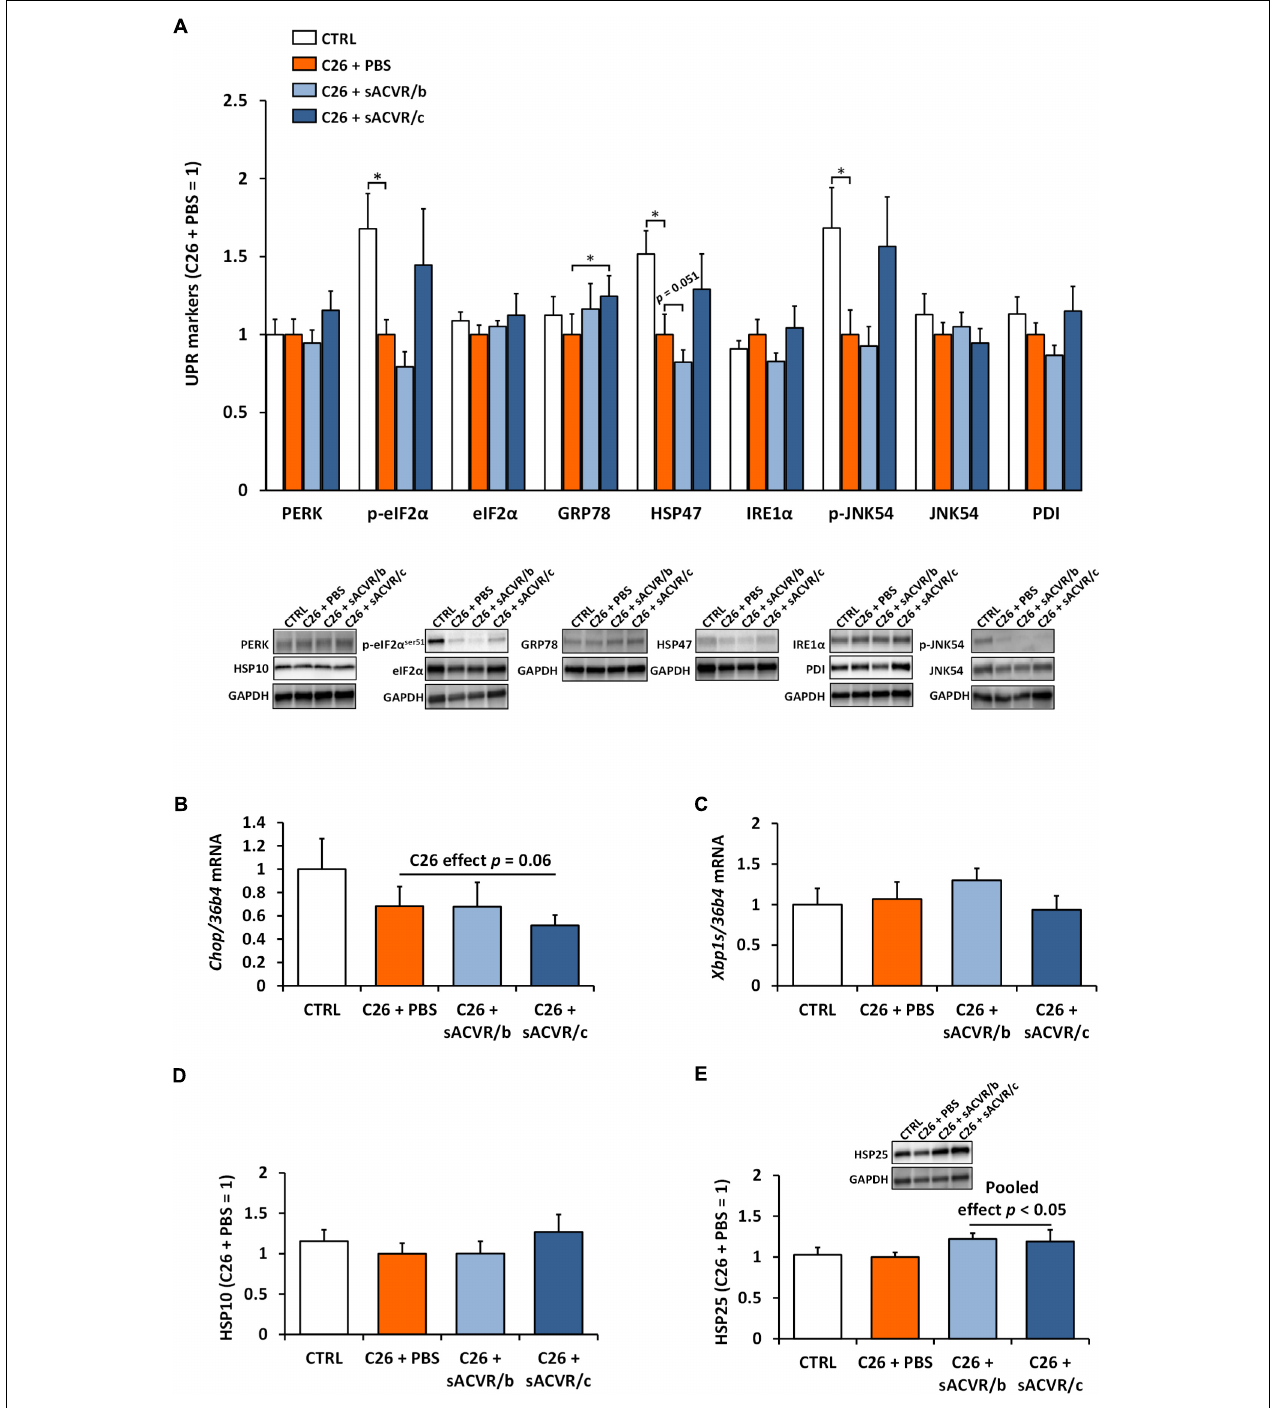
FIGURE 6 | Unfolded protein response (UPR) and heat shock protein (HSP) response markers in skeletal muscle of C26 tumor-bearing mice. (A) Protein content of UPR markers (PERK, p-eIF2 α ser51 , eIF2 α , GRP78, HSP47, IRE1 α , p-JNK54, JNK54, and PDI), (B) mRNA level of Chop , and (C) of spliced Xbp1 (Xbp1s) . (D) Protein content of HSP10 and (E) HSP25. CTRL, vehicle-treated (PBS) healthy control mice, n = 7. C26 + PBS = C26 tumor-bearing mice administered with a vehicle (PBS), n = 7. C26 + sACVR/b = C26 tumor-bearing mice administered with sACVR before the tumor formation and replaced by a vehicle (PBS) after the tumor formation, n = 7. C26 + sACVR/c = C26 tumor-bearing mice continuously administered with sACVR throughout the experiment, n = 8. The symbol ∗ depicts statistical significance p < 0.05. For the C26 effect all the tumor-bearing groups were pooled. For the sACVR pooled effect both of the sACVR groups were pooled. Data is expressed as means ± SE. Representative blots were cropped from the original blot images ( Supplementary Figures 9 , 10 ). Representative blots with same IDs and analyzed in the same run are aligned on top of each other and share the same representative control blot (GAPDH).